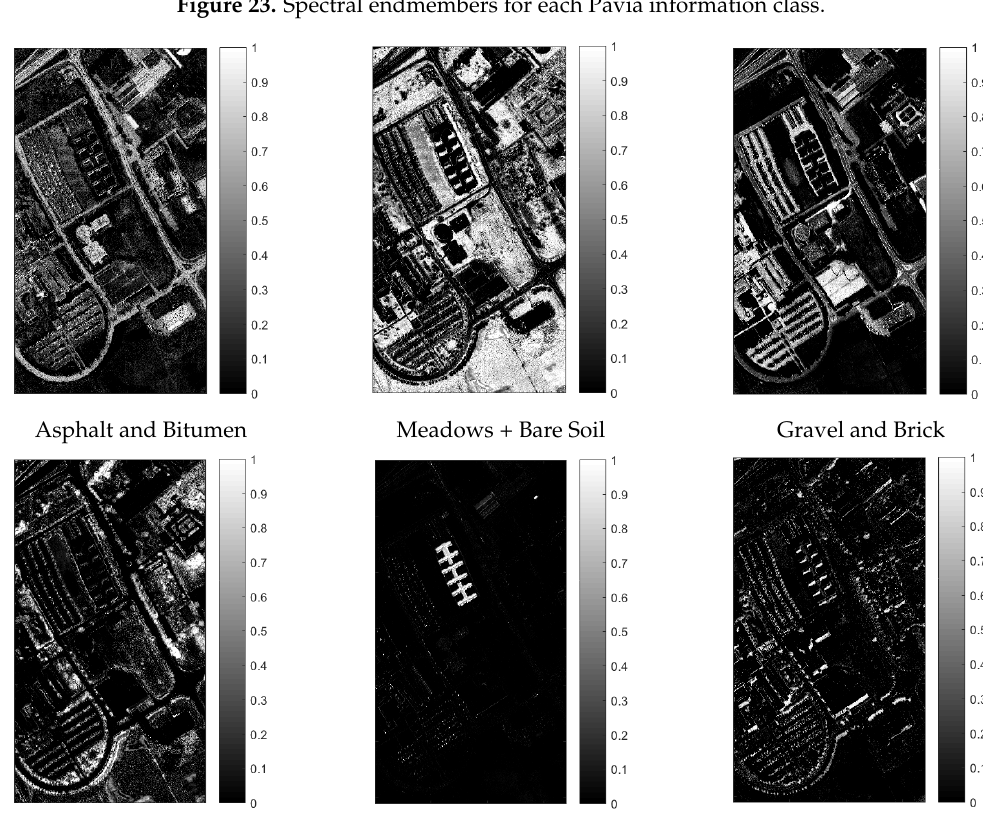
Figure 24. Abundances for Pavia information